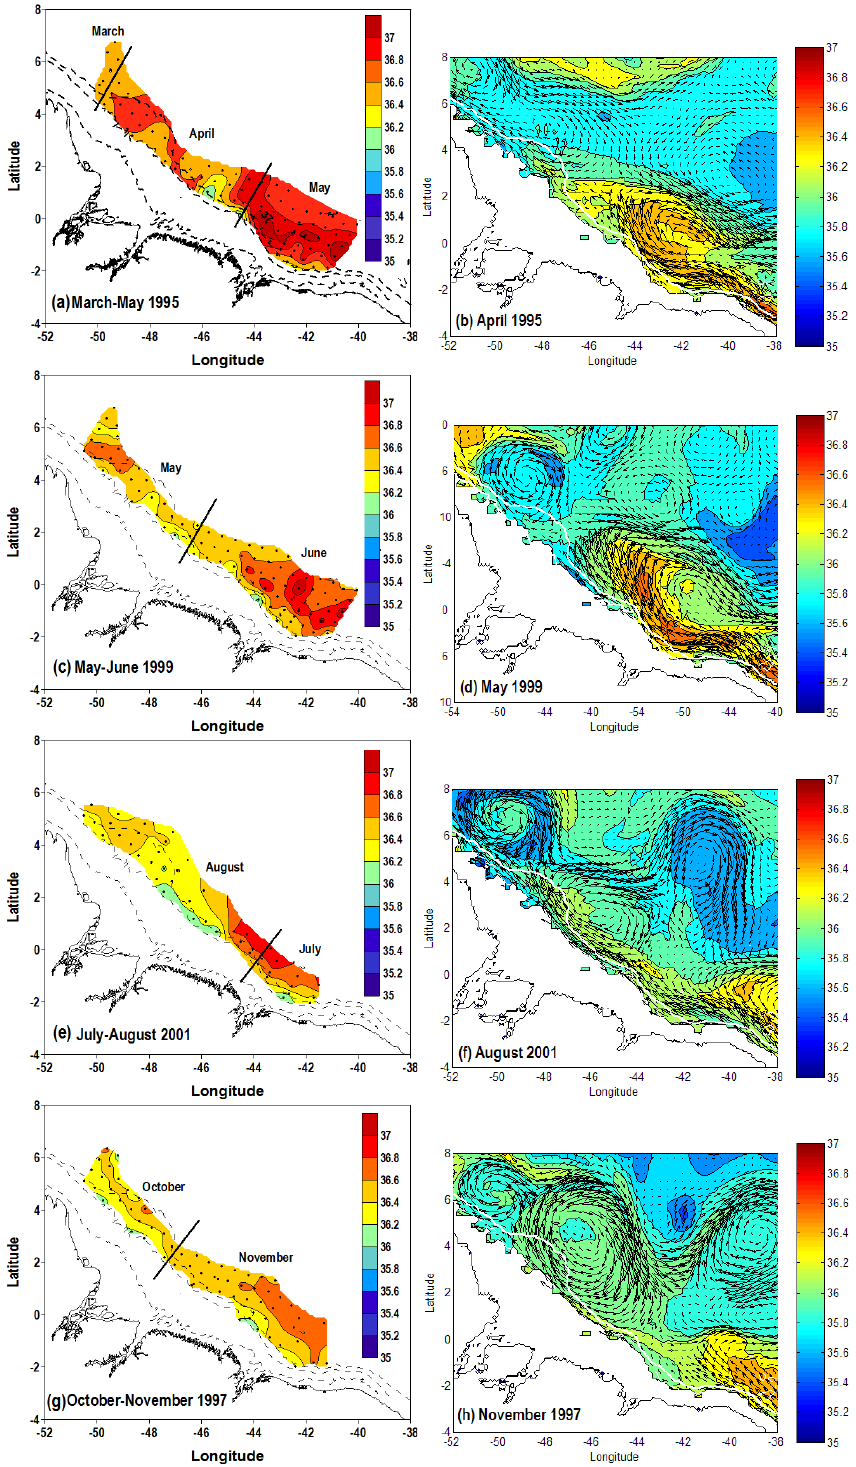
Fig. 4. Horizontal distribution of salinity and velocity during REVIZEE cruises and from CLIPPER model results along σ θ = 24.5kgm − 3 : (a) hydrographic data for March–May 1995, (b) model results for April 1995, (c) hydrographic data for May–June 1999, (d) model results for May 1999, (e) hydrographic data for July–August 2001, (f) model results for August 2001, (g) hydrographic data for October–November 1997, (h) model results for November 1997. Dashed lines represent the isobaths 20m, 100m and 2000m. The black lines perpendicular to the coast define each month of the